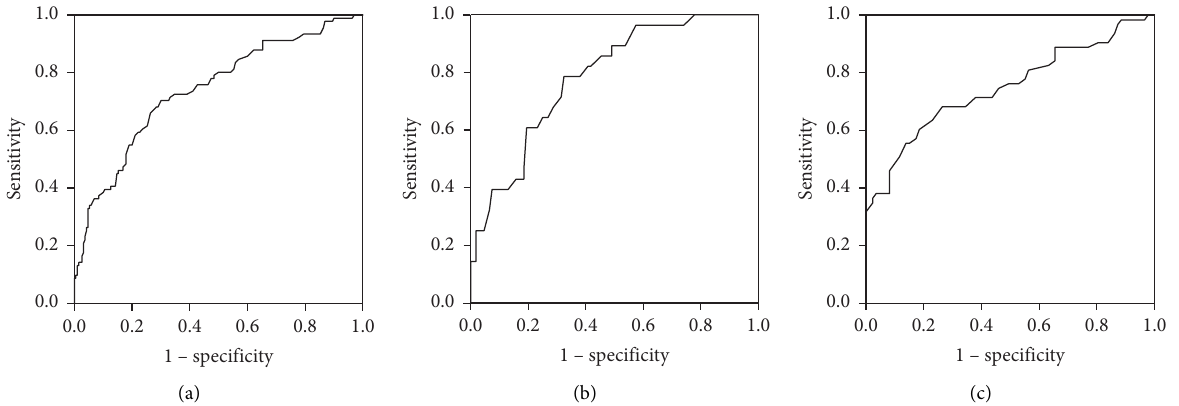
Figure 1: ROC curves of haemorrhage volumes predicted by pelvic free fluid depths. The haemorrhage volumes were predicted by standardised pelvic free fluid depths evaluated by TVS and TAS in panel a, by the raw depth of TVS in panel b and raw depths of TAS in panel c separately. TAS: transabdominal ultrasonography; TVS: transvaginal Ultrasonography; Se: sensitivity; Sp: specificity. (a) Hae- morrhage volume predicted by standardised depth measured by TVS and TAS, (b) haemorrhage volume predicted by raw depth measured by TVS, and (c) haemorrhage volume predicted by raw depth measured by